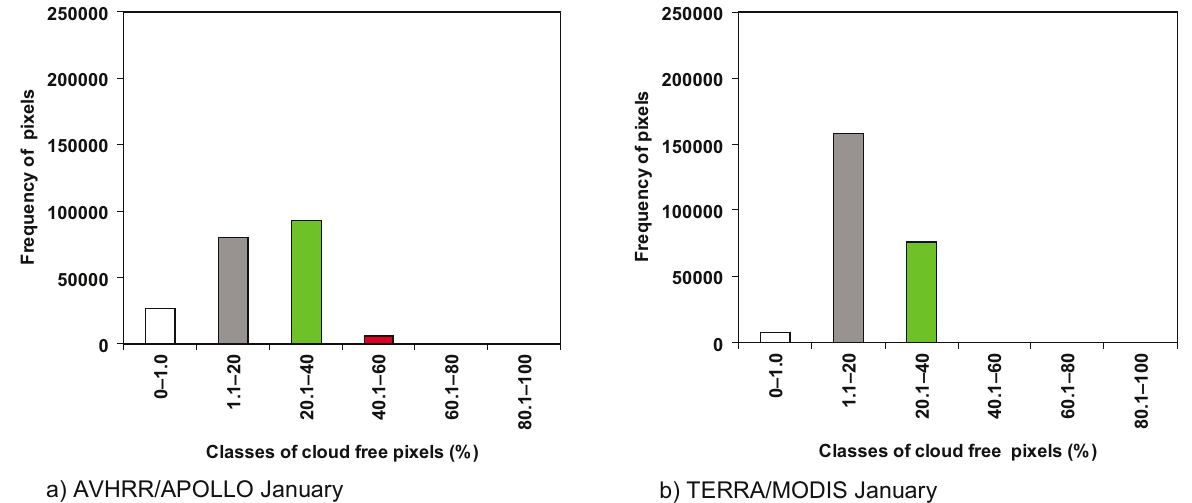
Fig. 2. Histogram of monthly cloud-free pixels in the